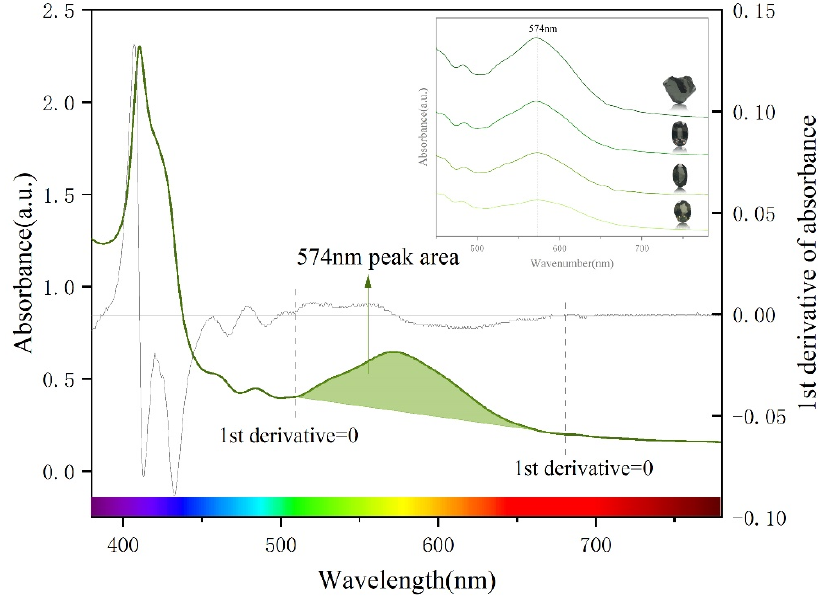
Figure 9. The area of the absorption peak at 574 nm affects the colour-changing garnet. Taking sample B3 as an example, the gray line is the first derivative curve of its UV-Vis spectrum, and the point where the first derivative is equal to zero is selected as the starting and ending points of the range at 574 nm absorption peak.